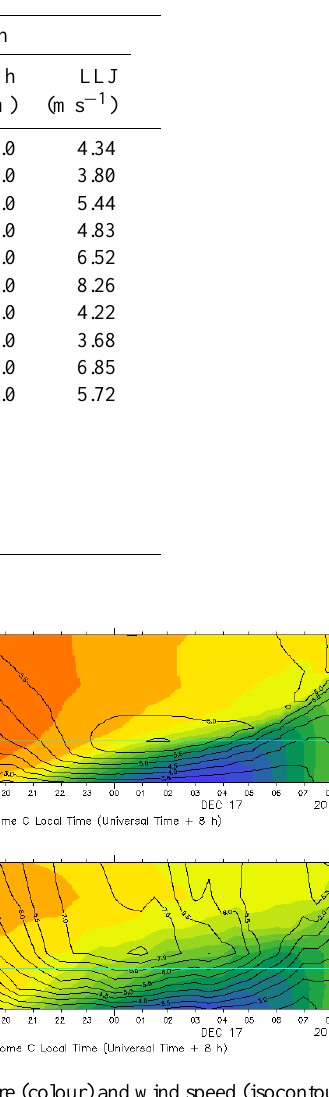
Figure 2. Temperature (colour) and wind speed (isocontours) at the Dome C tower, simulated by MAR on 16–17 December 2011 (up- per panel) and observed (lower panel). Local Time LT (Universal Time UT + 8h) is used. The simulated jet level is at z = 14ma . g . l . (shown by a cyan line in both